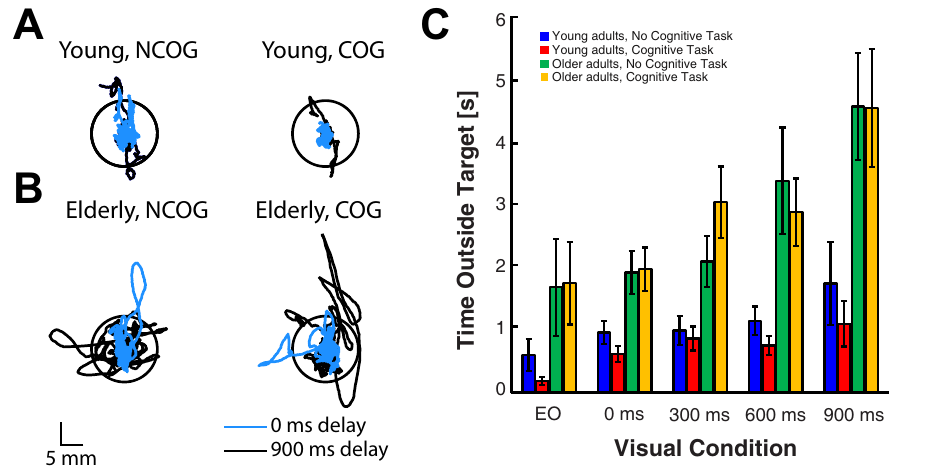
Figure 2. Comparison of COP displacements exhibited during simultaneous cognitive task performance and delayed visual feedback in young and older adults. A. COP data from a single trial performed by a representative young subject. Black circle corresponds to the COP target. Cyan traces show data from the 0 ms condition (instantaneous feedback) and black traces correspond to the 900 ms visual feedback delay condition. Representative COP data from the 0 ms and 900 ms delay conditions are shown with (right column) and without (left column) simultaneous cognitive performance. B. Same format as in A, but COP data are from a single trial performed by a representative older adult. C. Summary plot showing the time spent outside of the postural target. Error bars represent 6 1 SEM.